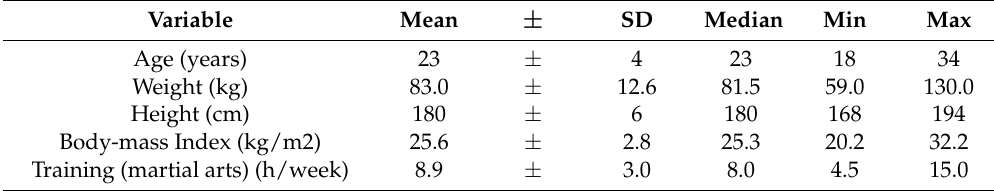
Table 1. Characteristics of Study Participants ( n =